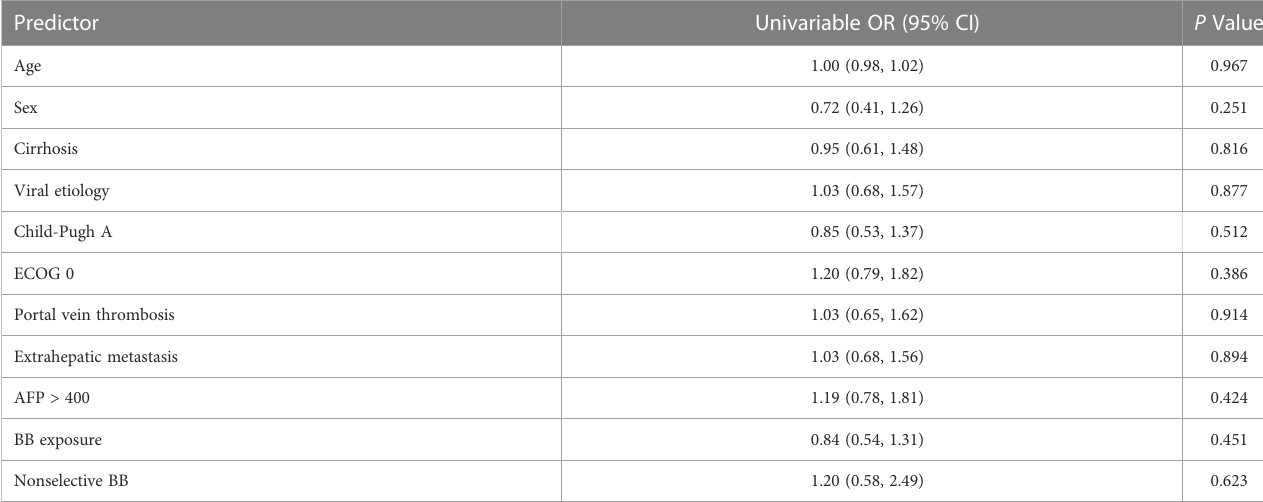
TABLE 5 Univariable hazard model for objective